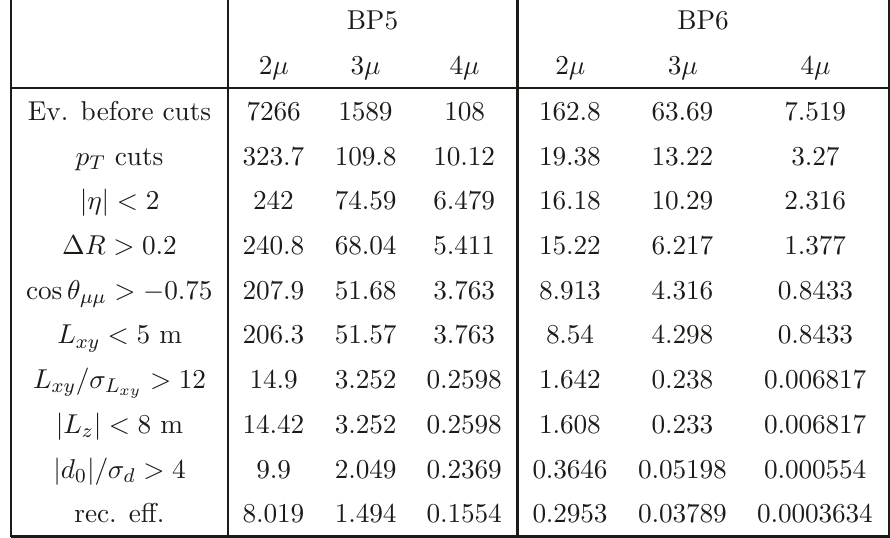
Table 10. Displaced muons in the muon chambers originated from heavy neutrinos produced by the heavy Higgs. For each BP the initial number of events generated is the cross section σ ( pp H 2 ν h ν h ) multiplied by a luminosity of 100fb − 1 . The p T cuts are applied in the → → following way: p T > 26 GeV for the two most energetic muons and p T > 5 GeV for all the others. The reconstruction efficiency of the muons is taken into account.